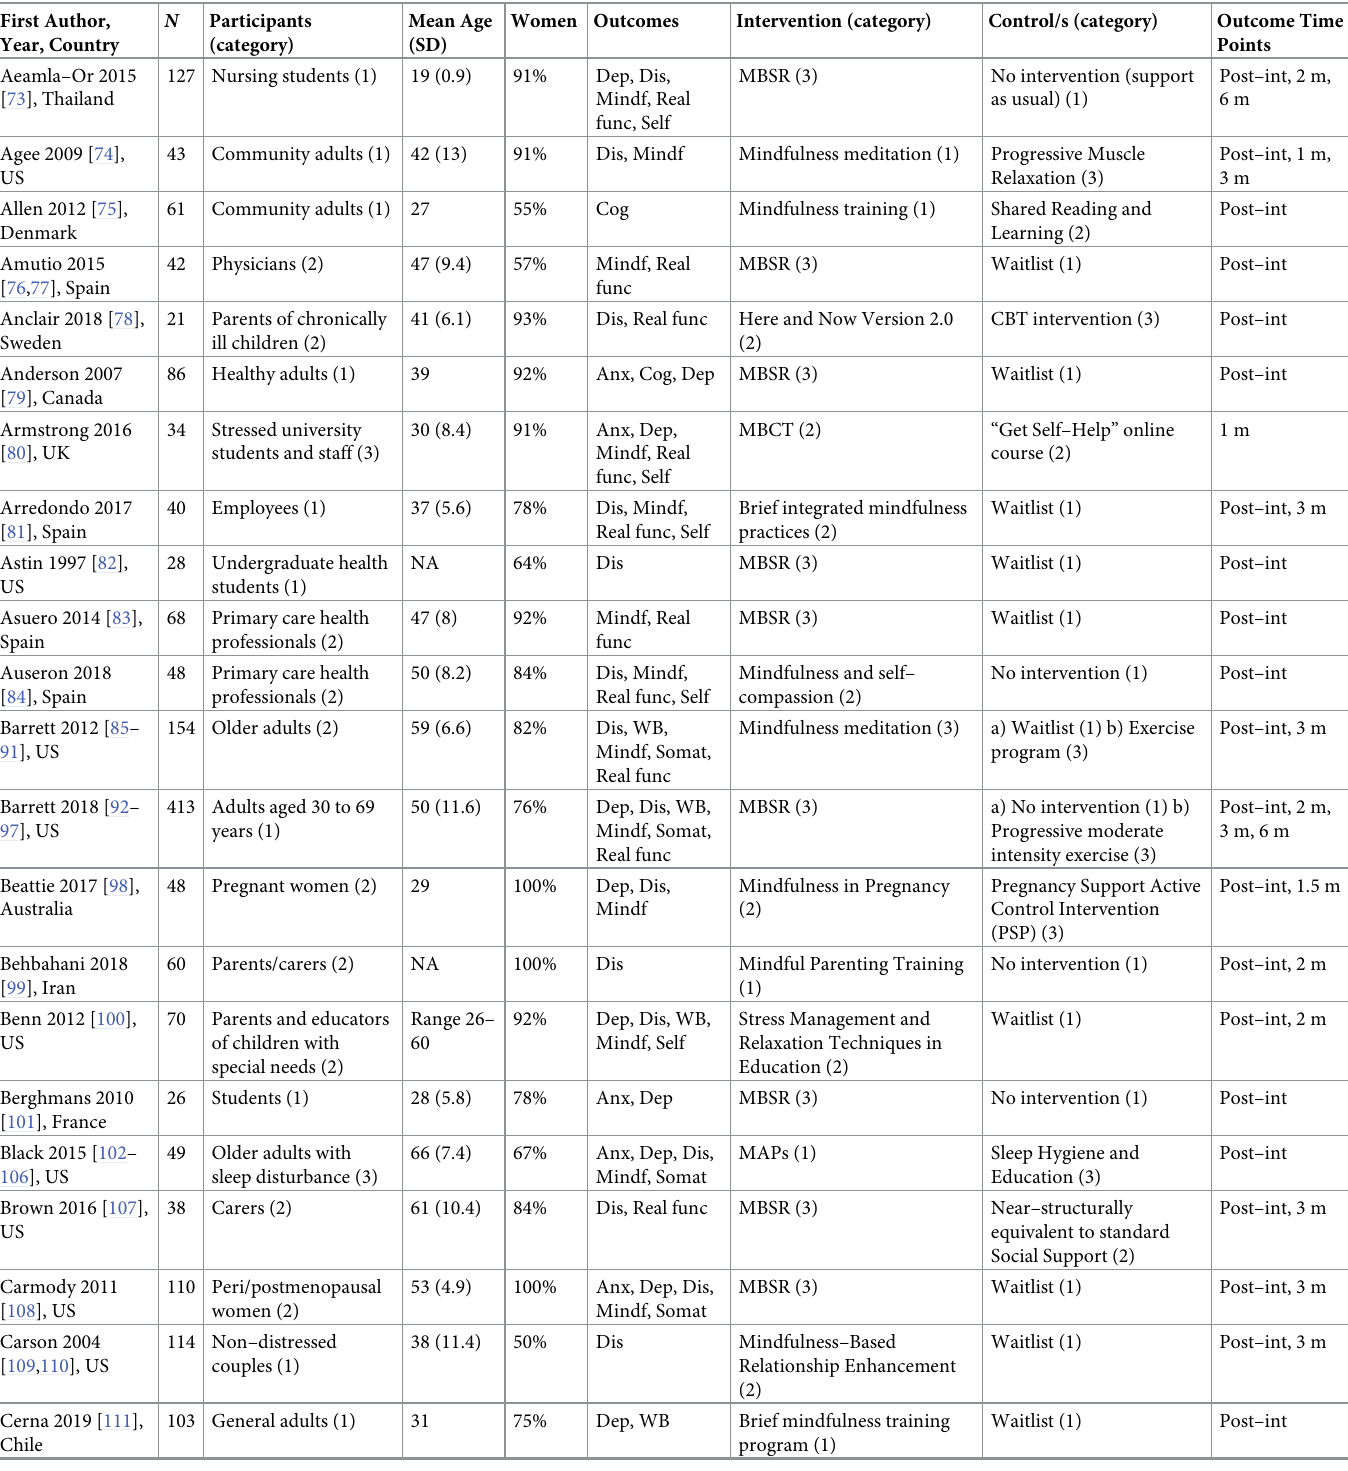
Table 1. Characteristics of included